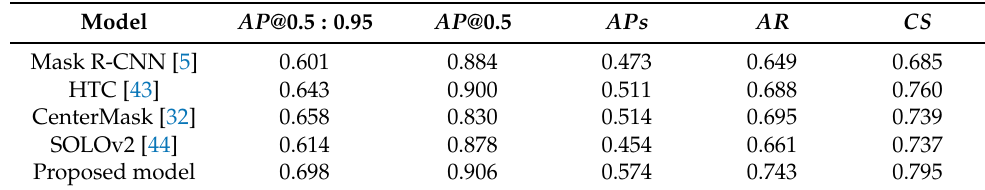
Table 1. Comparison of different network extraction methods on the WHU aerial image dataset. The best results are highlighted in bold.